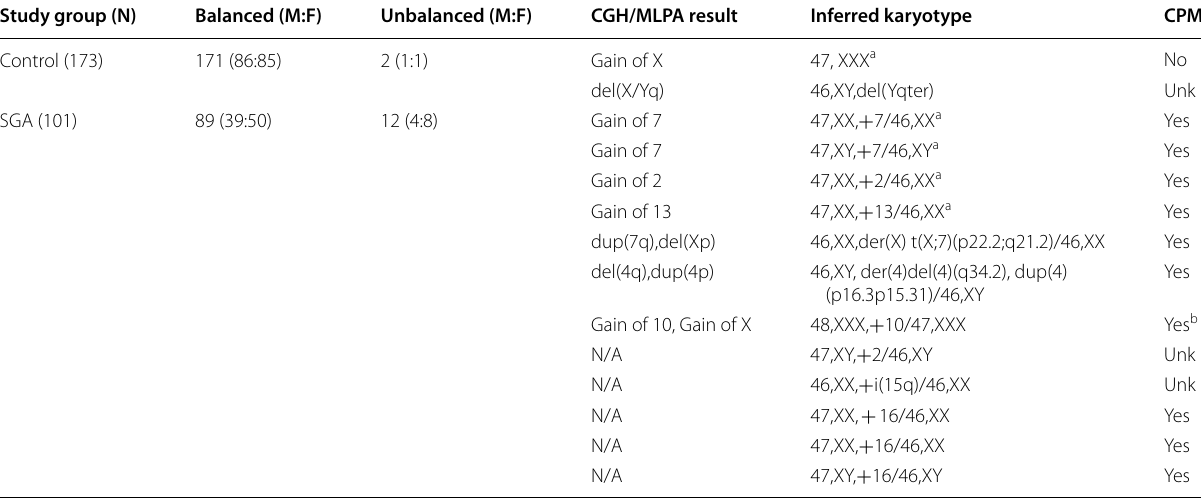
Table 2 Summary of findings from detection of placental